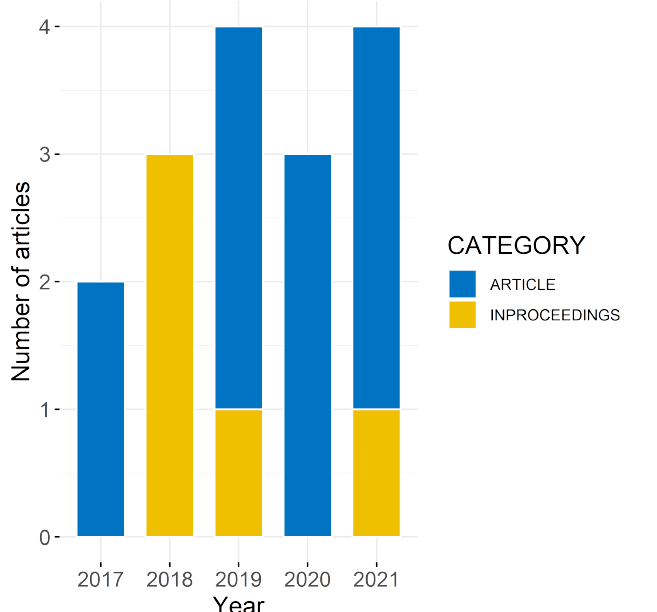
Figure 3. Distribution of included journal articles and conference proceedings between 2017 and